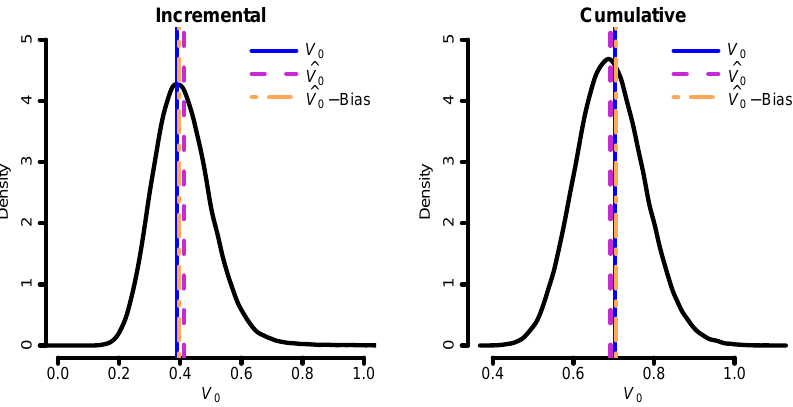
Figure 3. Distribution of the cost-of-capital margin for the incremental model (left) and the cumulative model (right). Values are in